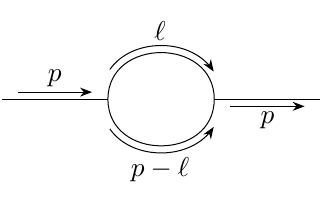
Figure 19 . One loop contribution to the scalar propagator of the particle A